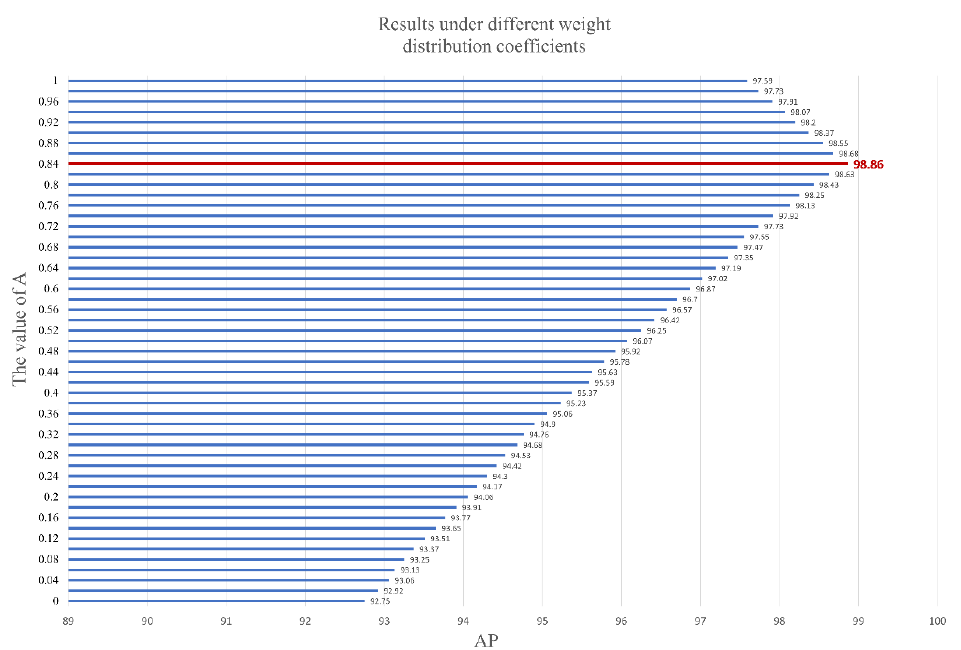
Figure 6. Correspondence between AP and the weight assignment factor. The red line indicates the best result.